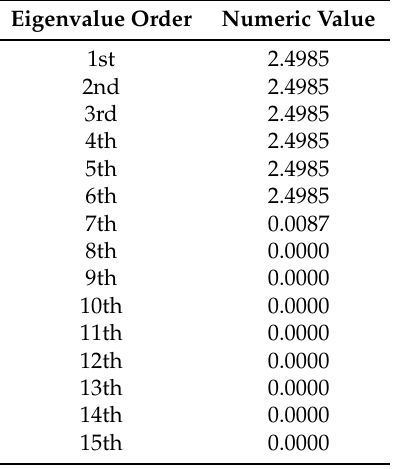
Table 1. Stationary eigenvalues ( t = 60 min) of the covariance matrix in the simulated test.